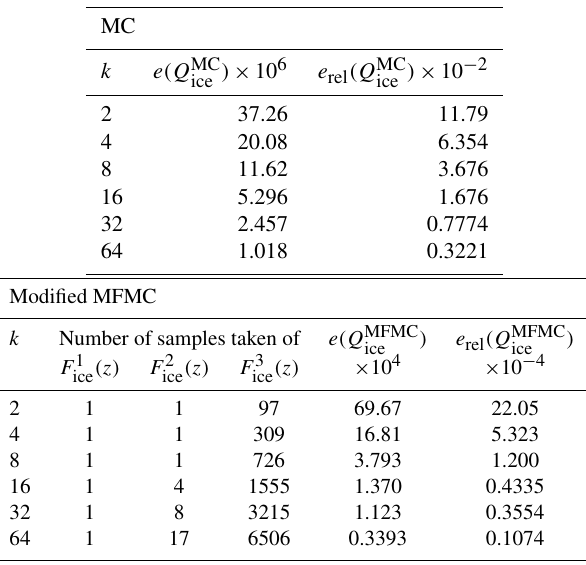
Table 6. Results of the ice sheet experiment for budgets equivalent to 2 k high-fidelity